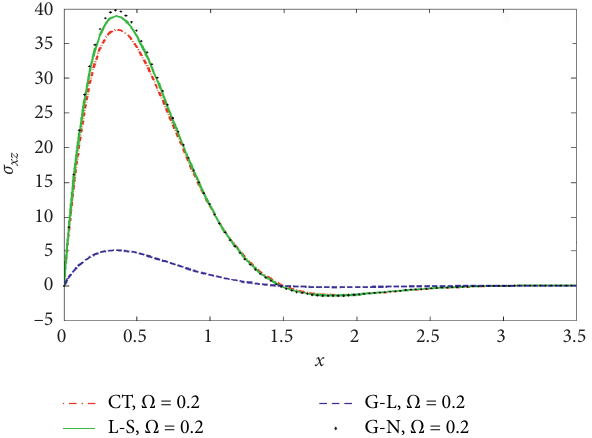
Figure 8: Stress τ theories.